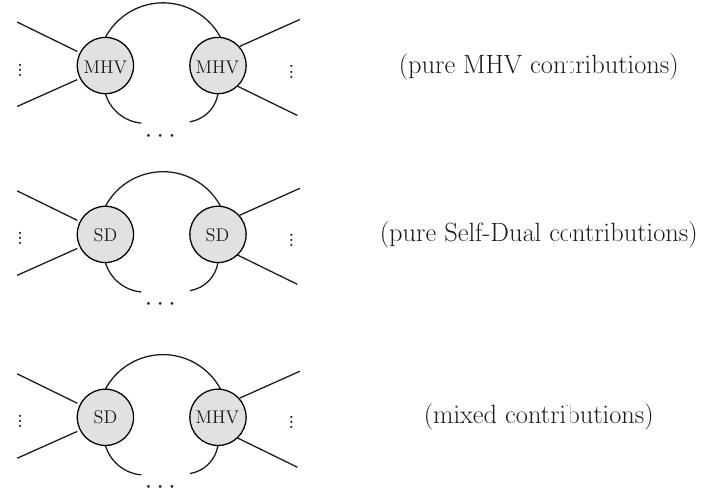
Figure 7 . Types of one-loop diagrams originating in the effective action for the MHV theory. The first class (top) are diagrams that involve only MHV vertices in the loop. These are the diagrams that would follow from classical MHV action. In addition to that, the one-loop effective action generates diagrams which involve pure Self-Dual interactions in the loop (middle), as well as the mixed contributions